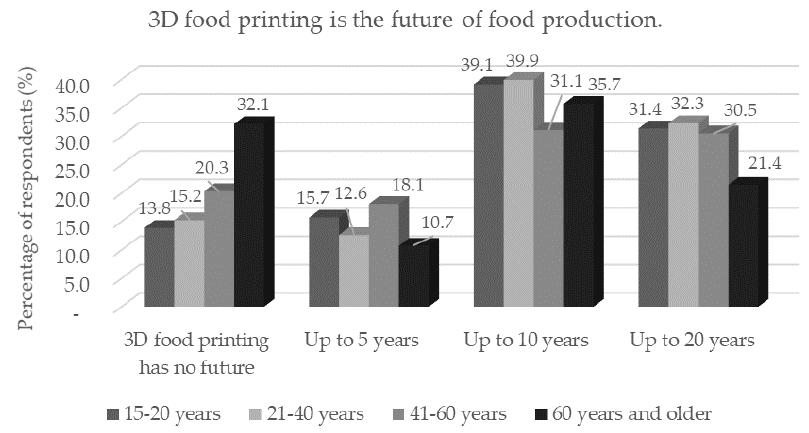
Figure 13. Respondents’ opinions on the application of 3D food printing by age category in response to the statement: “3D food printing is the future of food production.” Table 4. Three-Dimensional Food Printing, Application. Distribution of respondents (%).